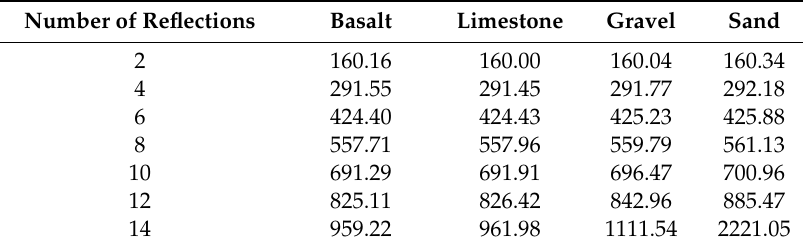
Table 7. Results of delay for di ff erent